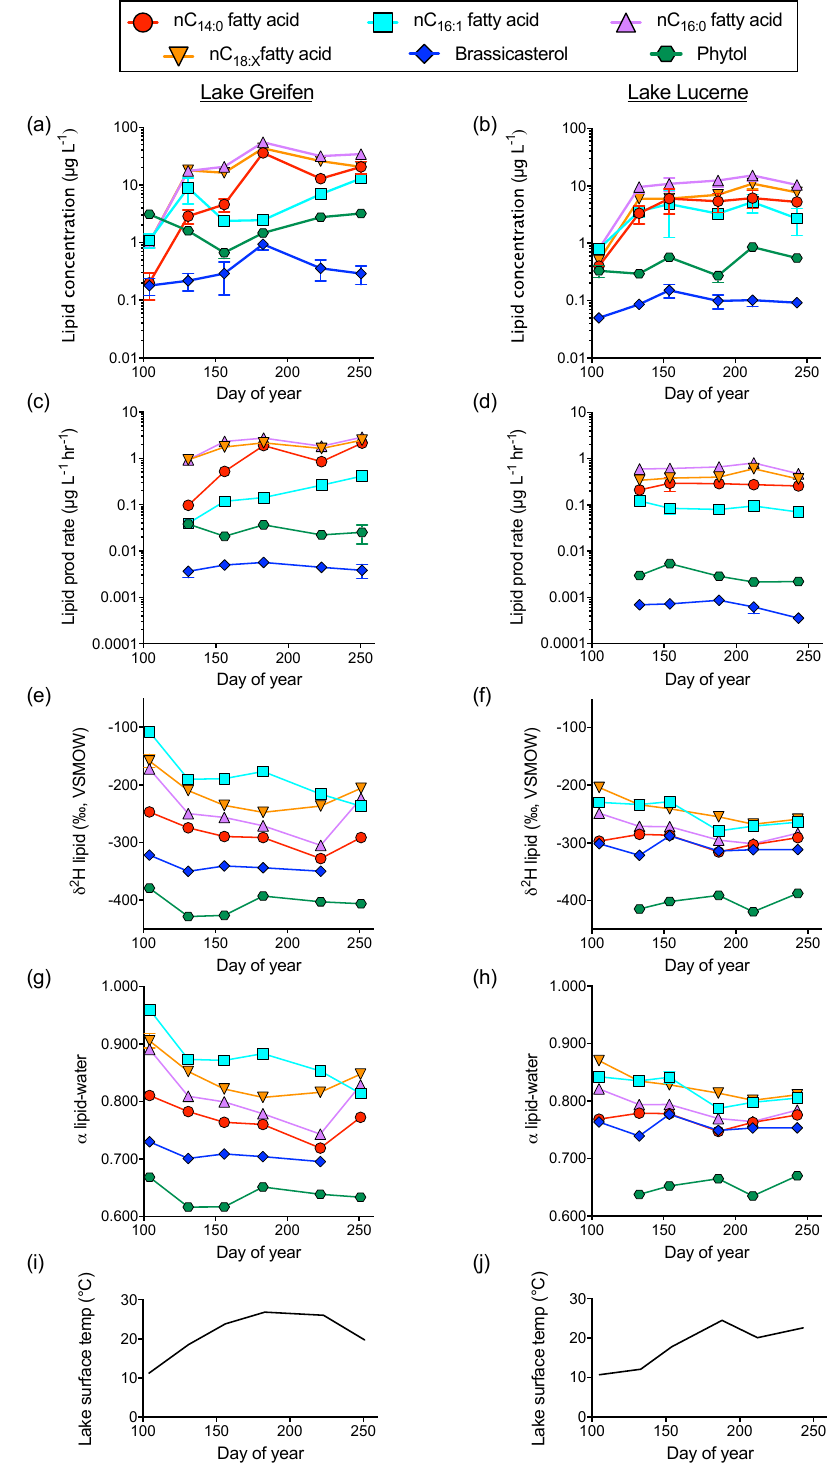
Figure 2. Time series of lipid concentrations in µgL − 1 (panels a and b ), lipid production rates in µgL − 1 h − 1 (panels c and d ), lipid δ 2 H values in ‰ relative to VSMOW (panels e and f , α lipid-water values (panels g and h ), and lake surface temperature (panels i and j ) for Lake Greifen (left column) and Lake Lucerne (right column) during the spring and summer of 2015. Panels (a–d) are plotted on an exponential scale to accommodate the large range of lipid concentrations and production rates. Error bars represent 1 SD of replicate measurements and are propagated to include uncertainties from multiple sources in calculated production rates and α lipid-water values. In cases where error bars are not visible, they are smaller than the marker